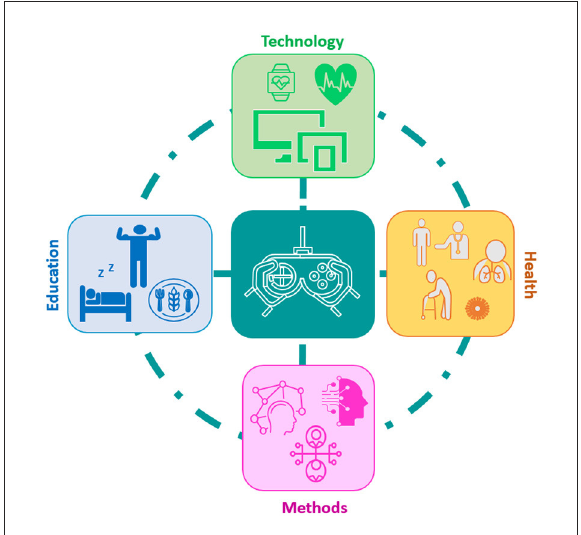
FIGURE1 Application areas of Human-Computer Interaction Serious Games, ranging from educational games to games for health and behavior change, along with biosensing technology and computational